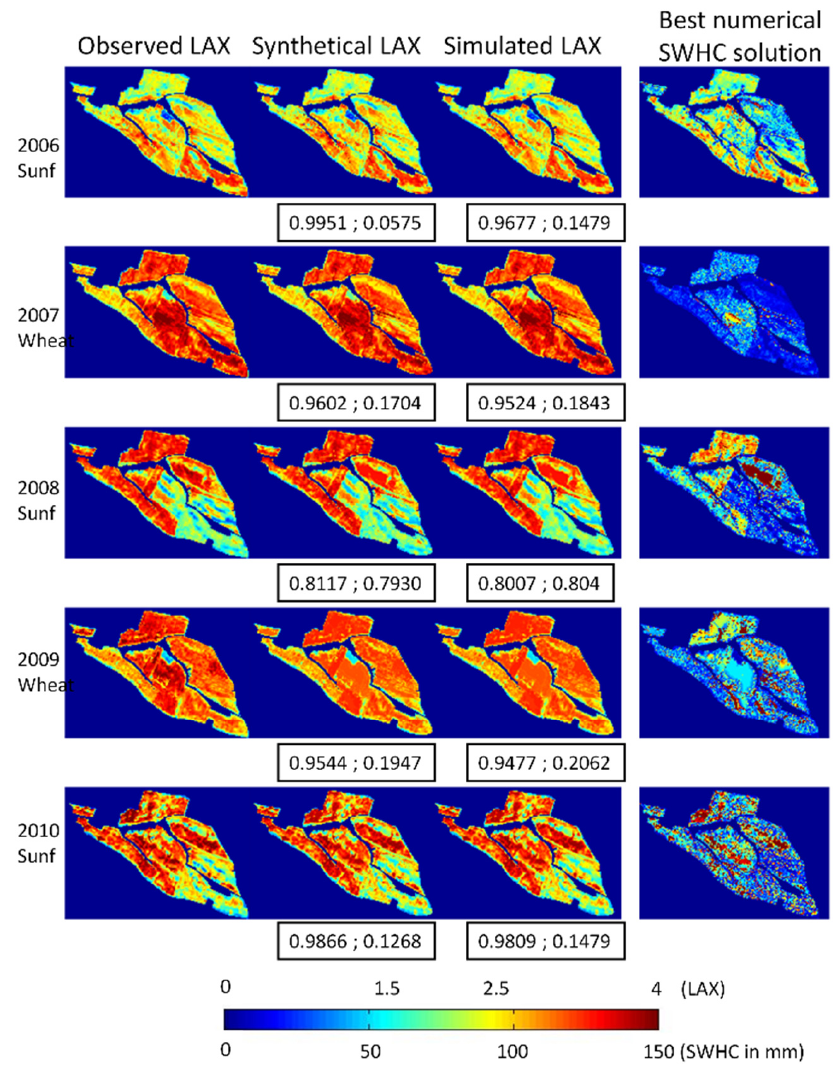
Figure 5. Observed, synthetic and simulated LAX (in column) for each year (in line). The fourth column represents the best numerical solution of SWHC for each year selected from the best fit between synthetic LAX (second column) and observed LAX (first column). The third column shows simulated LAX after having reset soil parameters using the best numerical solution of the fourth column. Numbers in the boxes represent the correlation coefficient and the RMSE between synthetic and observed LAX (second column) and simulated and observed LAX (third column) for each year.